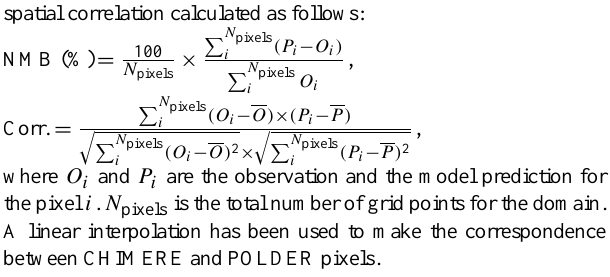
Table 3. Statistical comparison between CHIMERE and POLDER aerosol optical thickness for each day of the studied period. NMB and Corr. are, respectively, the normalized mean bias (in %) and the